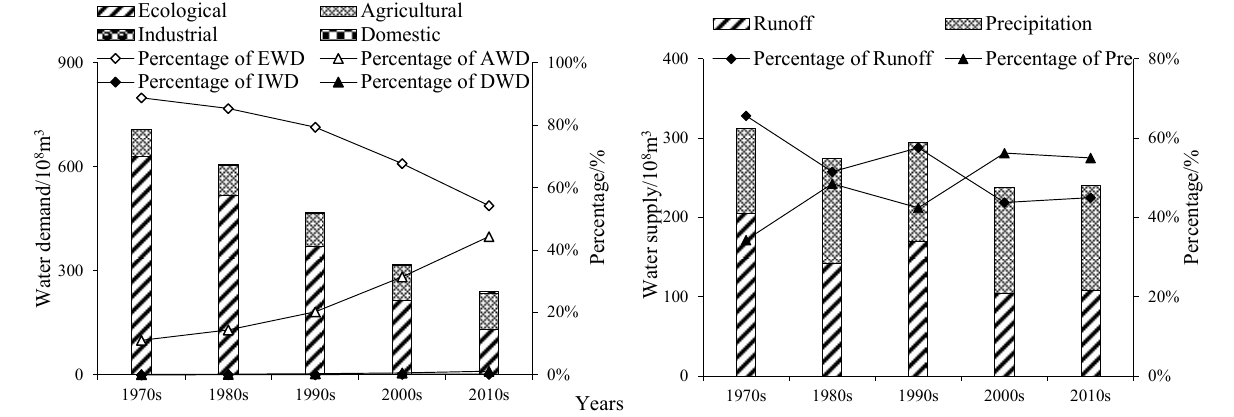
Figure 10. Composition changes of water demand and water supply in the LADB during the 1970s to the 2010s. Notes: EWD, ecological water demand; AWD, agricultural water demand; IWD, indus- trial water demand; DWD, domestic water demand.